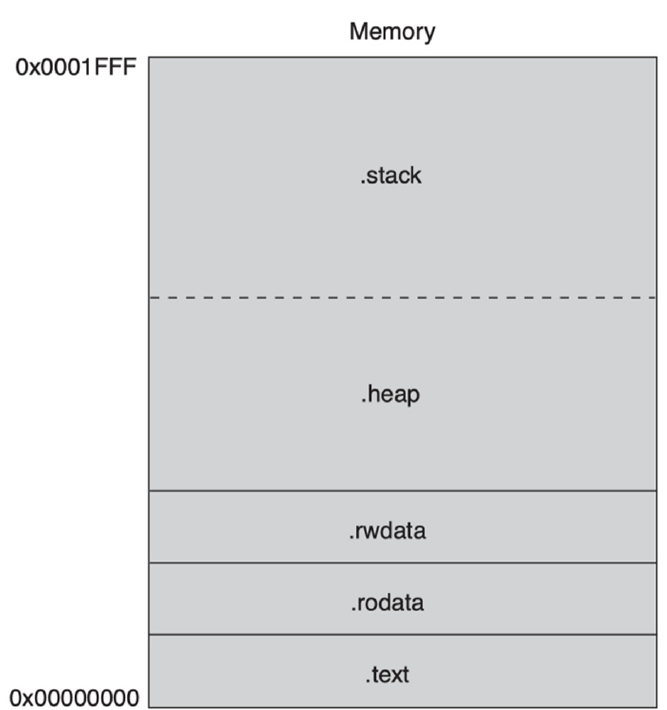
Figure 4. An NIOS II program in on-chip memory (on-chip RAM).